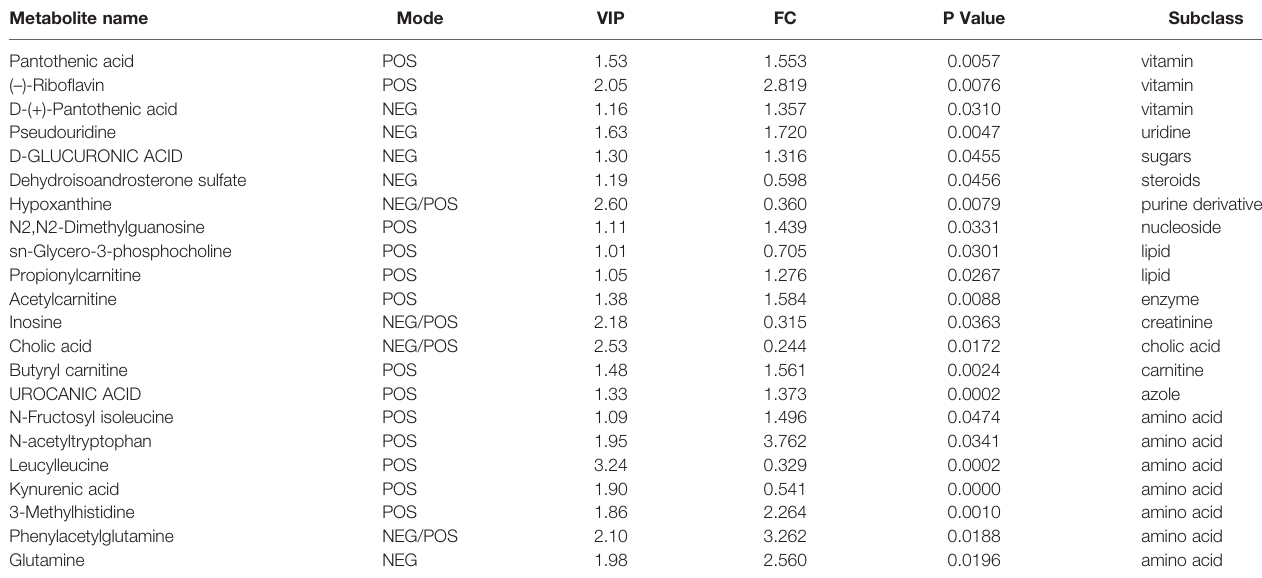
TABLE 2 | Differential metabolites identi fi ed from metabolomics pro fi ling.